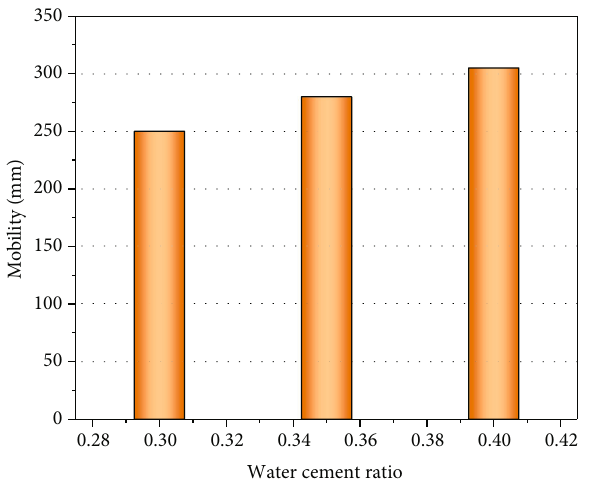
Figure 13: In fl uence of water-cement ratio on fl uidity.